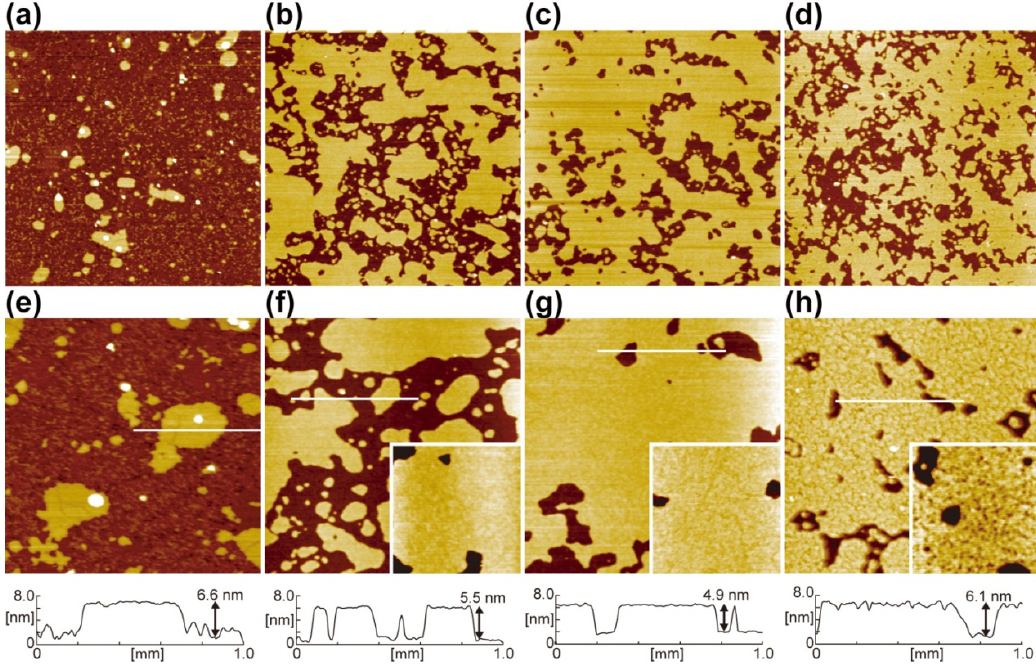
Figure 3. AFM topographies (( a )–( d ): 5.0 × 5.0  m 2 , ( e )–( h ): 2.0 × 2.0  m 2 ) and line profiles of hydrophilicity-controlled SiO /Si surfaces after the incubation at 0.005 mg mL − 1 of the 2 100-nm-filtred DMPC vesicle suspension. ( a , e ) Chemically oxidized SiO /Si without 2 annealing (WCA < 5°); ( b , f ) annealed at 480 °C for 10 min (WCA = 11°); ( c , g ) annealed at 700 °C for 10 min (WCA = 24°); and ( d , h ) annealed at 700 °C for 60 min (WCA = 67°); The insertions in ( f – h ) are magnified images (800 × 800 nm 2 ) of the SLB surfaces. Reproduced from [25] with modification by permission of the PCCP Owner